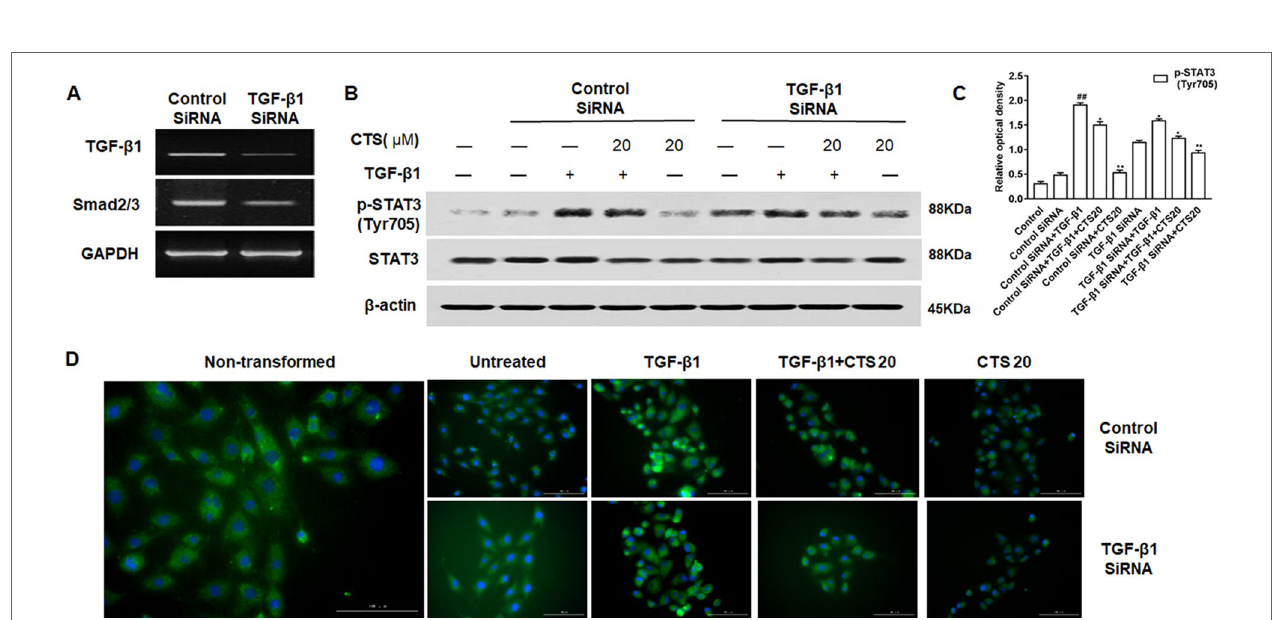
FIGURe 9 | The effect of transforming growth factor beta 1 (TGF-β1) low expression on the phosphorylation of STAT3 in the TGF-β1-induced airway smooth muscle cells (ASMCs). (A) The expressions of TGF-β1 and the phosphorylation of Smad2/3 in the TGF-β1-silenced ASMCs were verified by reverse transcription polymerase chain reaction. (B) The protein levels of p-STAT3 (Tyr705) and STAT3 in ASMCs were detected by Western blot after knockdown with TGF-β1 small interfering RNA. (C) Densitometric analysis was presented as the relative ratio of each molecule to Smad2/3, β-actin and STAT3. Data were presented as mean ± SEM (n = 3). ##P < 0.01 vs. untreated group; *P < 0.05, **P < 0.01 vs. TGF-β1-induced group. (D) The immunofluorescence analysis of p-STAT3 (Tyr705) in ASMCs showed that this protein was mainly expressed in the cytoplasm of ASMCs. Magnification: 200×. As shown in the pictures, p-STAT3 (Tyr705) was stained green and nuclei was stained with 4′,6-diamidino-2-phenylindole showing a blue color.